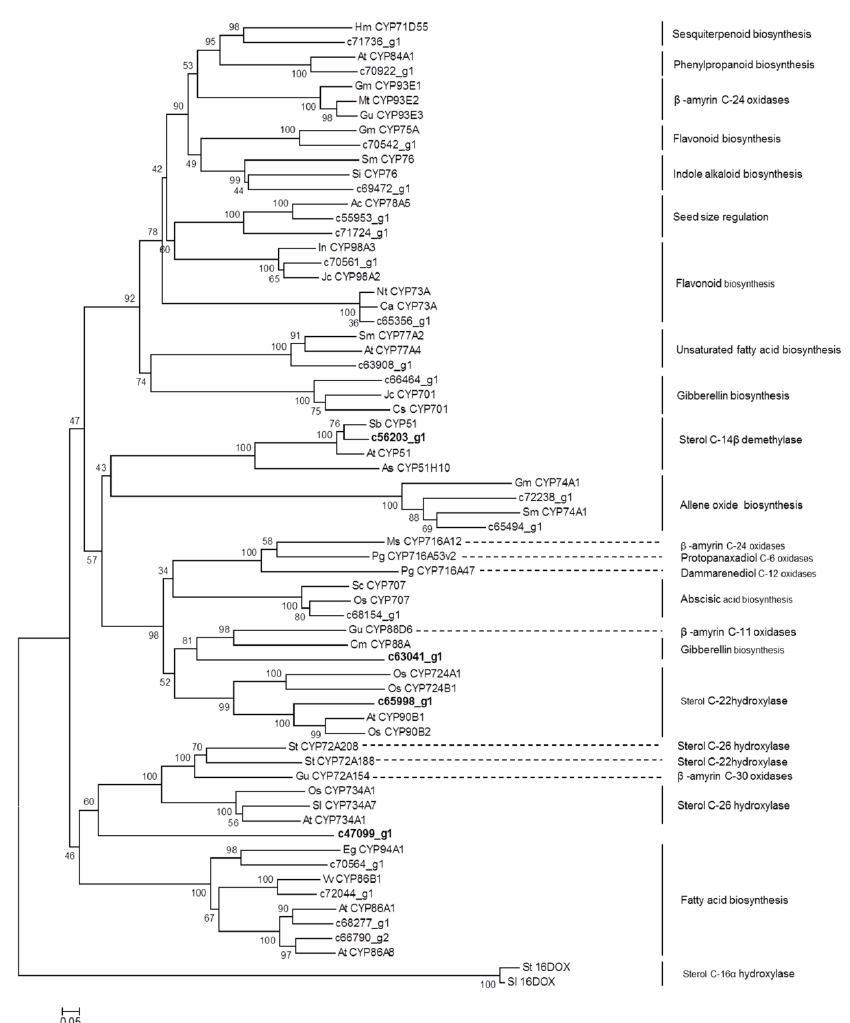
Figure 3. Phylogenetic analysis of potential CYP450 candidates from D. zingiberensis transcriptome with previously published CYP450s from various metabolic pathways.